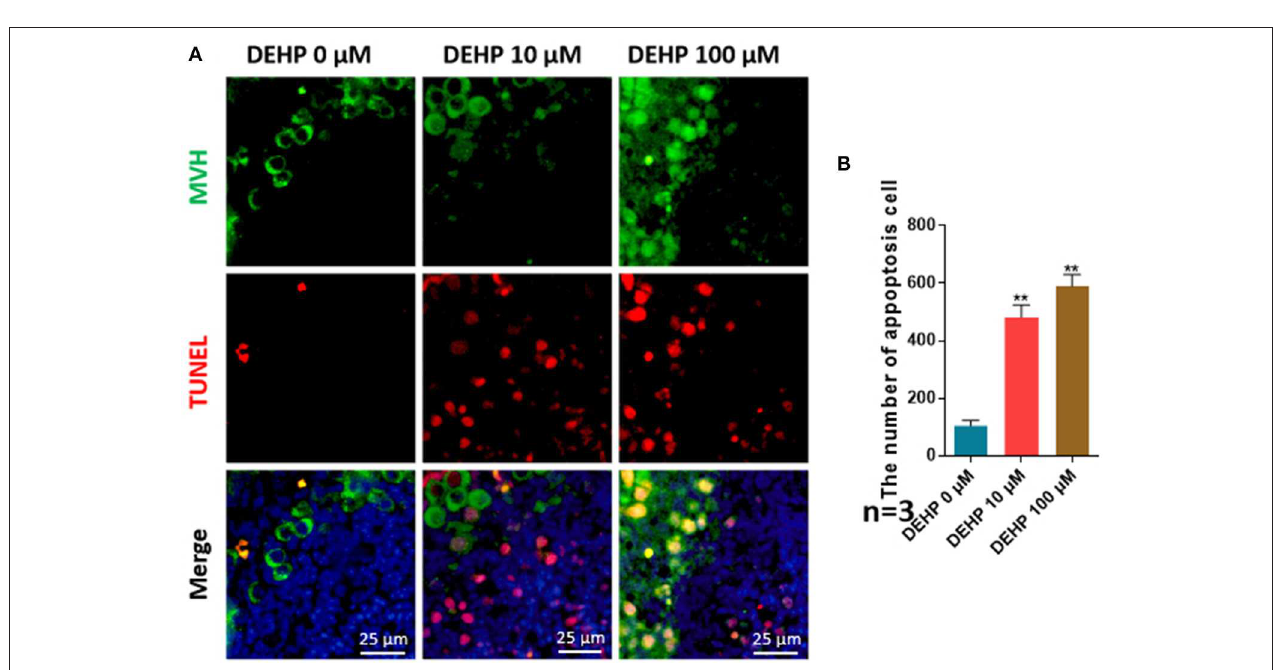
FIGURE 2 | DEHP induces the cell apoptosis. (A) Histological sections with TUNEL stainning. Oocytes are stained green with anti-Mvh antibody, apoptosis cells are marked red with TUNEL, nuclei are stained blue with Hochest 33342; (B) percentages of TUNEL positive oocytes. The results are presented as mean ± SD of at least three independent experiments. ** P <